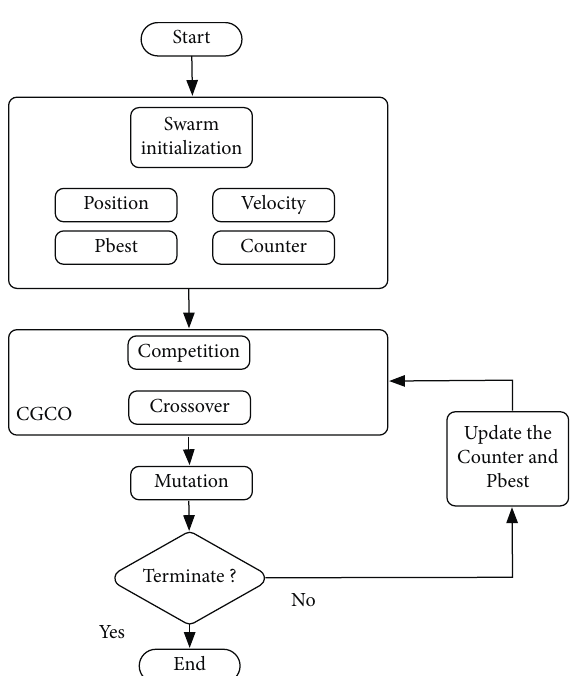
Figure 2: The flowchart of the proposed